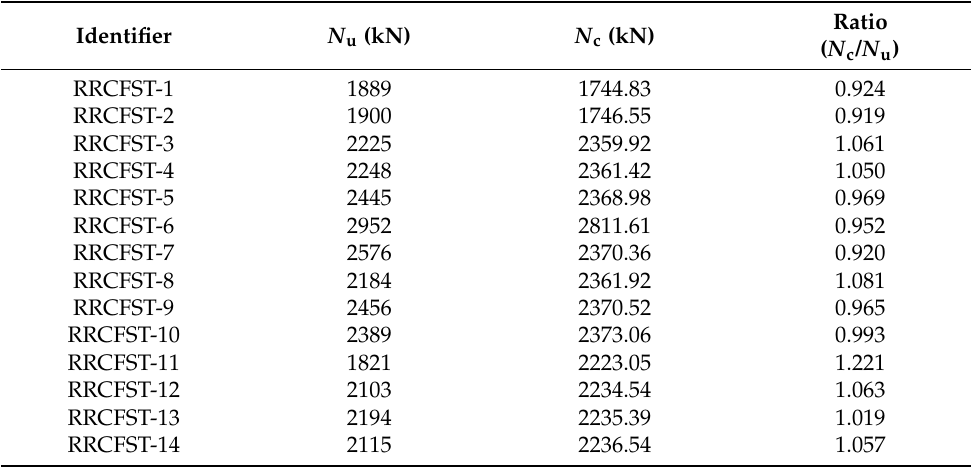
Table 4. Comparison of experimental and calculated bearing